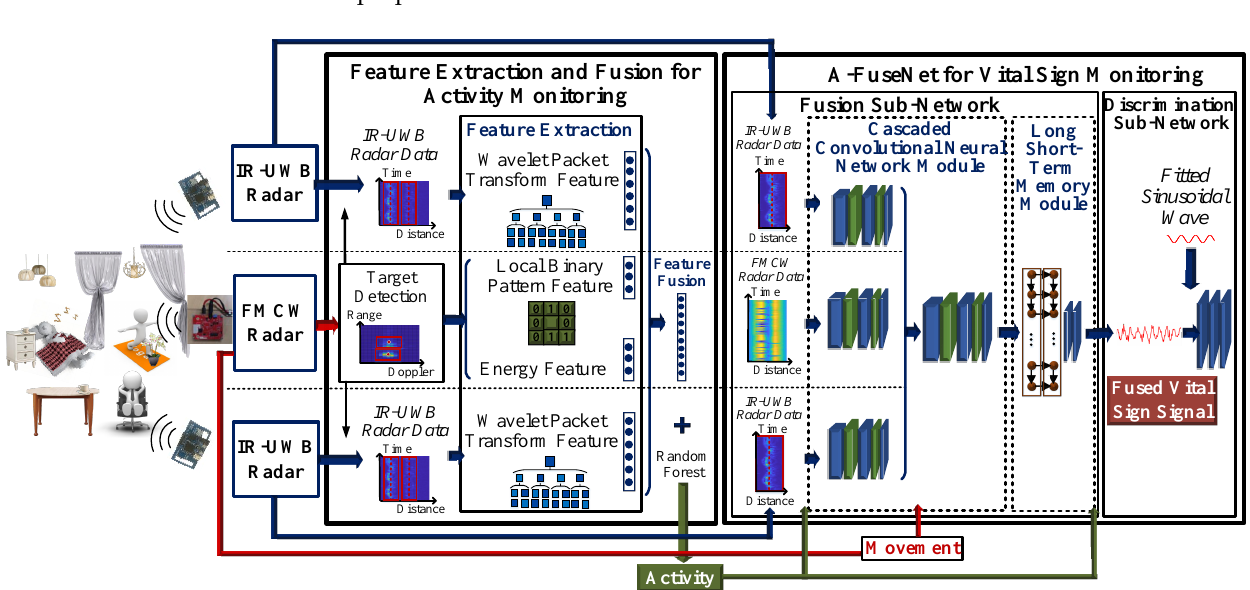
Figure 1. Flowchart of the proposed framework, composed by the feature extraction and fusion for activity monitoring and the A-FuseNet for vital sign